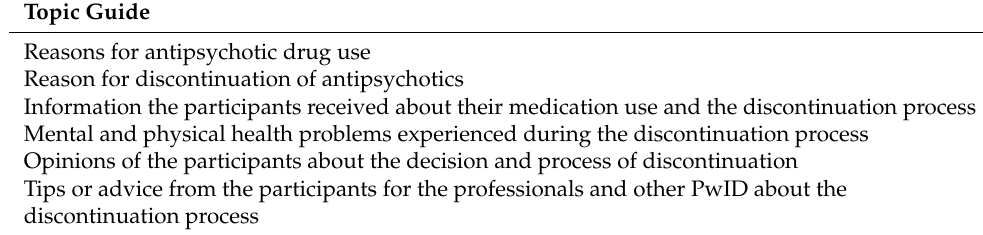
Table 1. Topic guide with subjects for interviews on users’ experiences with the withdrawal of